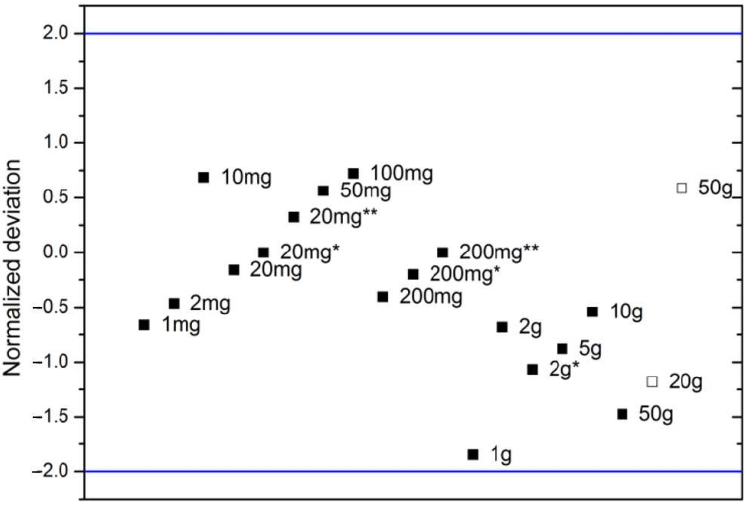
Figure 7. Consistency of mass values between calibrations, * and ** represent marking on the weight surface used to distinguish weights with the same nominal value.